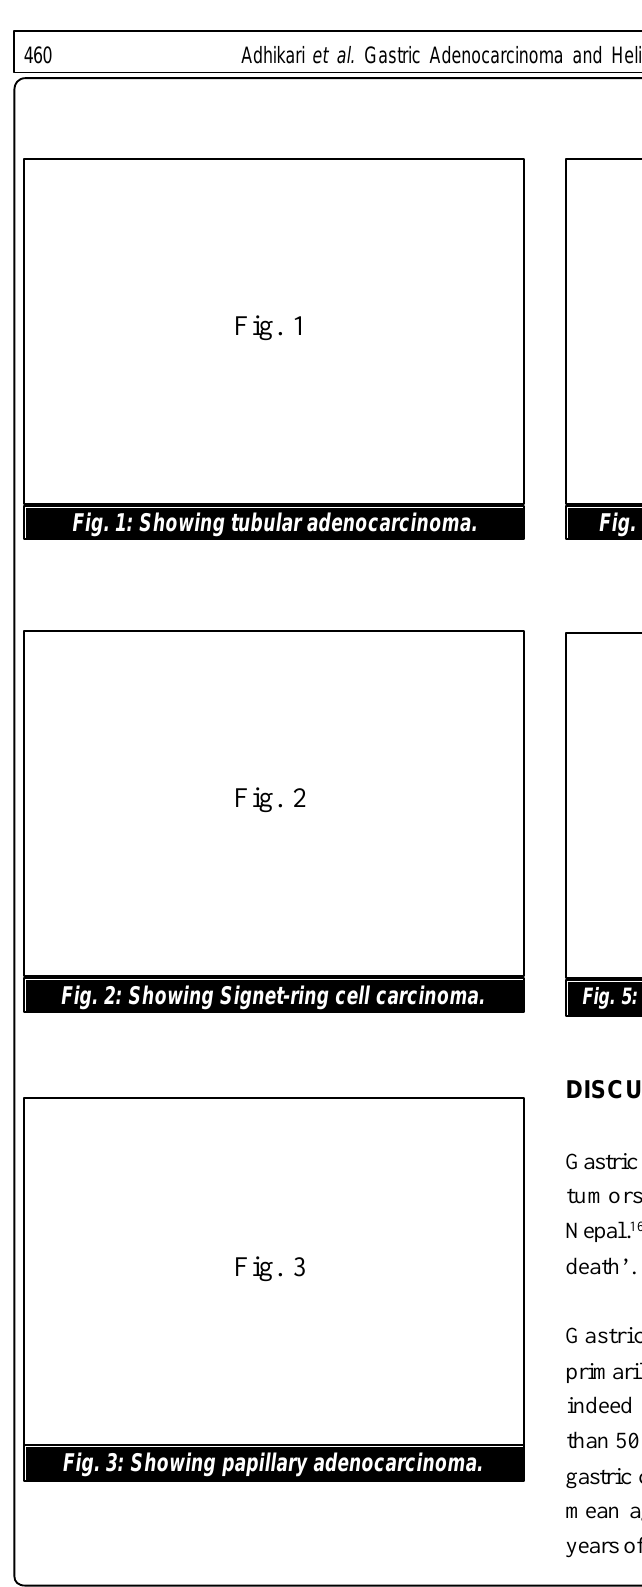
Fig. 1: Showing tubular adenocarcinoma.